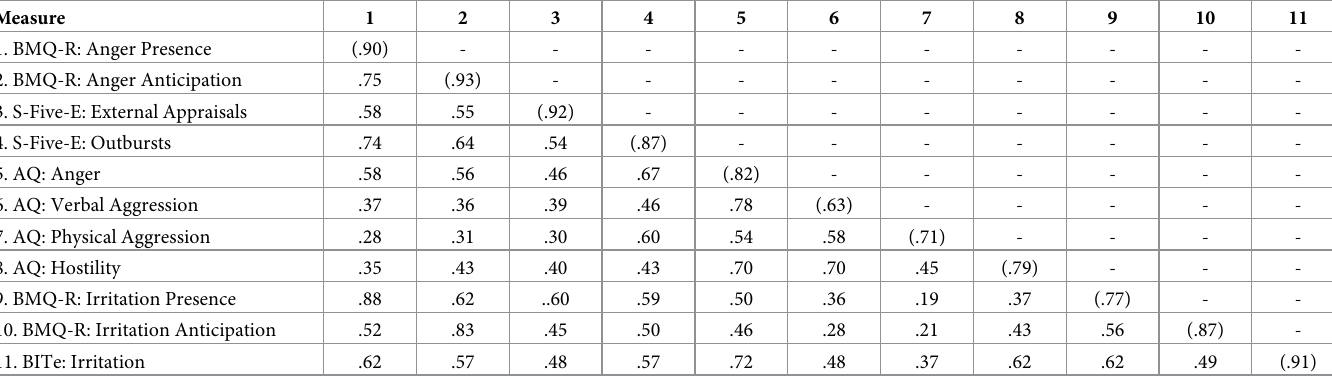
Table 5. Latent intercorrelations for misophonic anger and irritation reactions with convergent